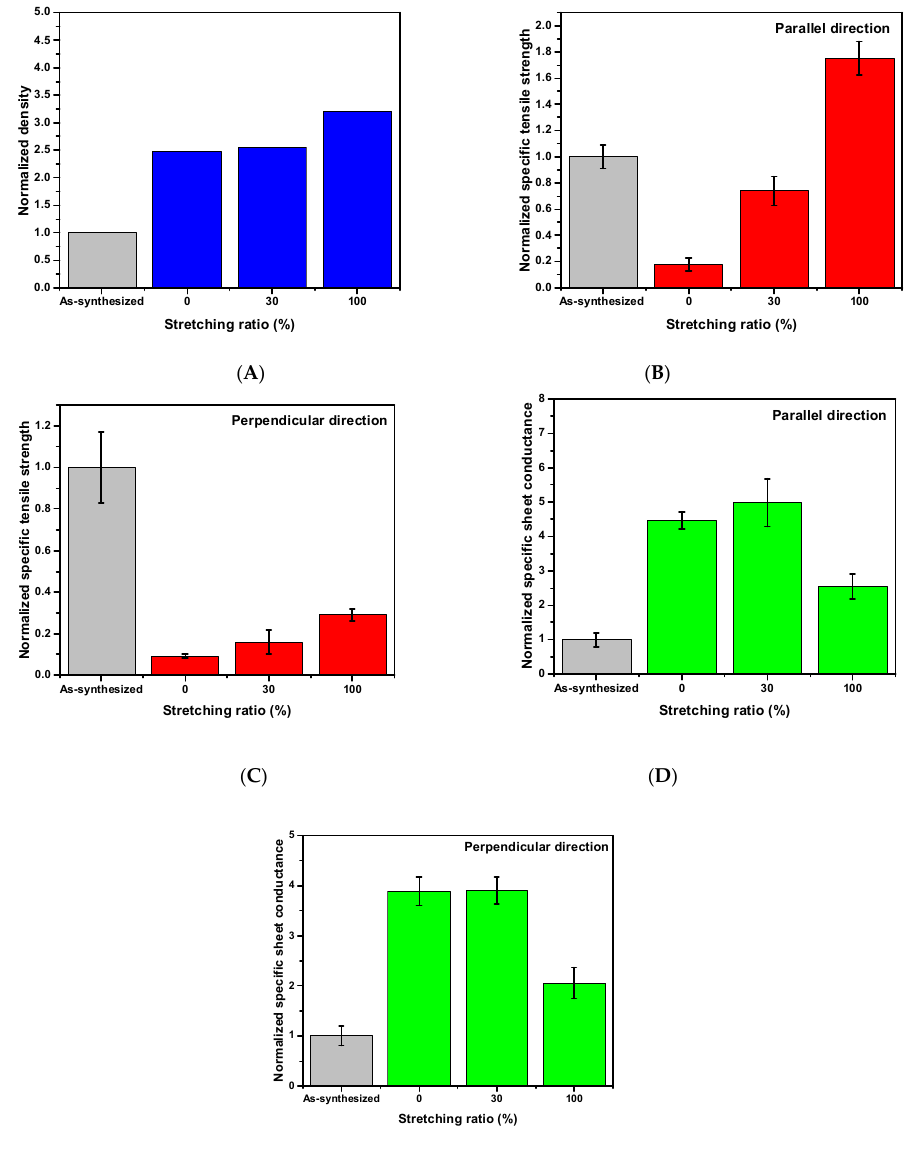
Figure 2. Evolutions in ( A ) normalized density, ( B ) normalized specific tensile strength in parallel direction, ( C ) normalized specific tensile strength in perpendicular direction, ( D ) normalized specific sheet conductance in parallel direction, and ( E ) normalized specific sheet conductance in perpendicular direction. During the CSA densification and stretching process, parallel direction refers to the winding direction from the synthesis process, whereas perpendicular direction indicates the direction perpendicular to winding direction. All values are normalized to those of as-synthesized CNT.